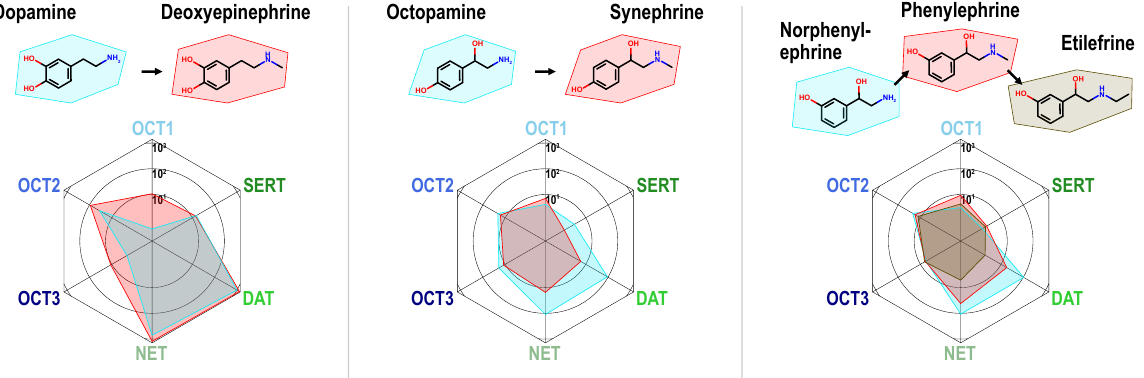
Figure 3. Alkylation of the primary amino group in phenylethylamines reduced uptake ratios of monoamine transporters and increased uptake by OCT1. Single N -methylated compounds are still good MAT substrates, but larger substituents as shown for the ethyl chain in etilefrine strongly reduce MAT